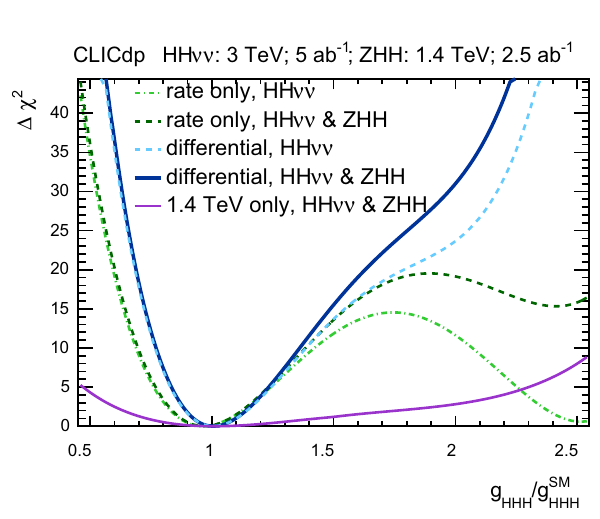
well as a mass eigenstate mixing with the SM-like Higgs boson. The new parameters are therefore the mass of the